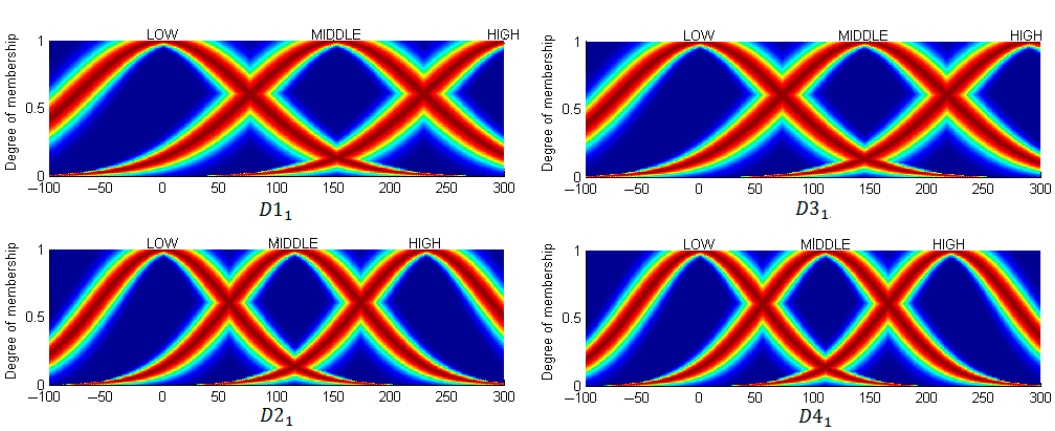
Figure 5. GT2 input membership function for the variables D 1 1 , D 2 1 , D 3 1 , and D 4 1 .